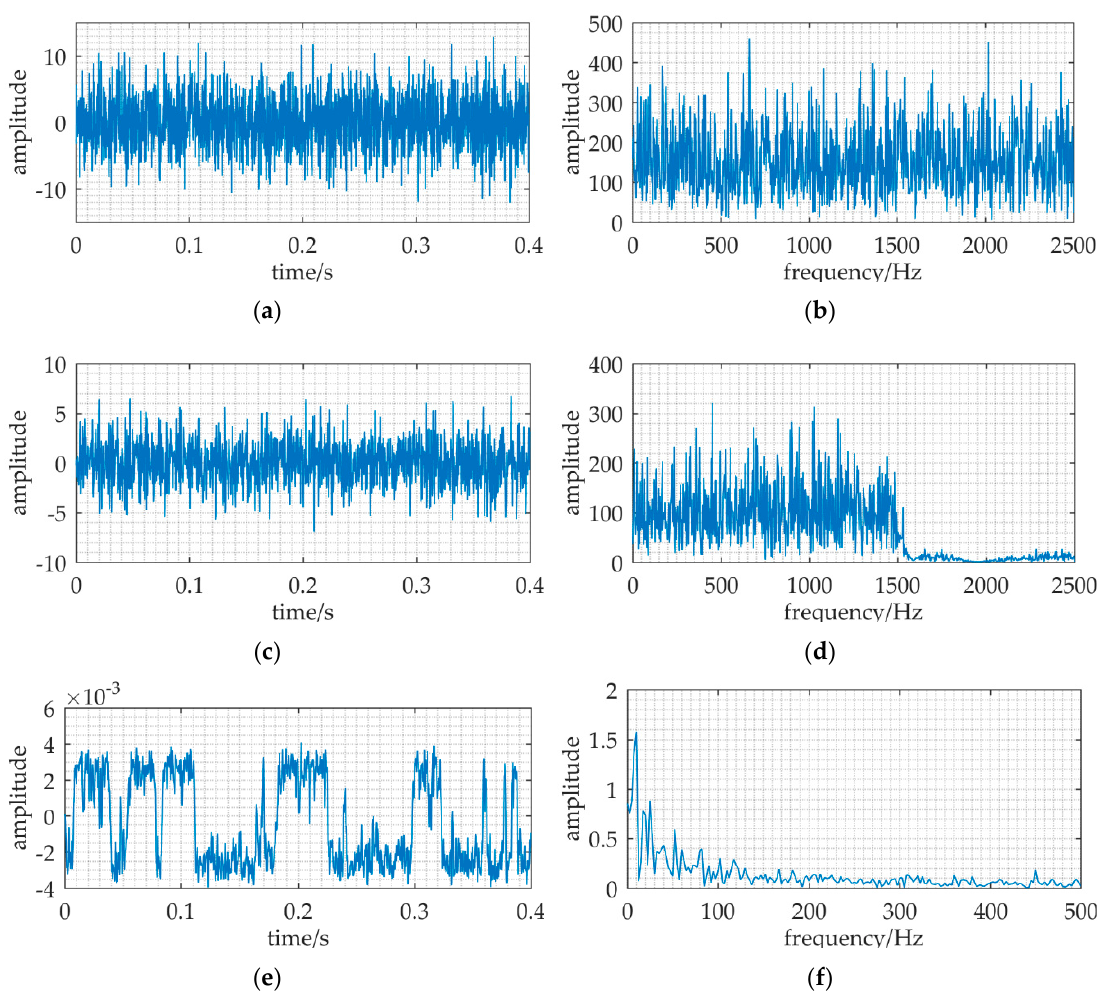
Figure 9. An example shown the effectivity of MNSR. The relative parameters: A = 0.5, f = 1000, a = 1000, b = 1.45×10 8 , f c = 990 Hz, D = 7.75, f s = 5000. (a) and (b) are the waveform and frequency spectrum of the input. (c) and (d) are the waveform and frequency spectrum of the low-pass filter output, m ( t ). (e) and (f) are the waveform and frequency spectrum of the MNSR output.